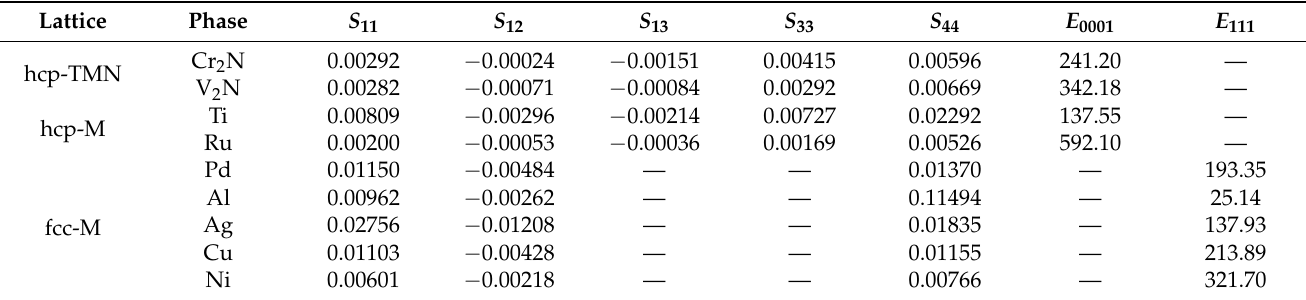
Table 5. Calculated elastic compliances ( S ij , in GPa − 1 ), Young’s moduli ( E , in GPa) along [0001] direction for Cr 2 N, V 2 N, Ti, and Ru, and along [111] direction for Ni, Pd, Al, Ag, and